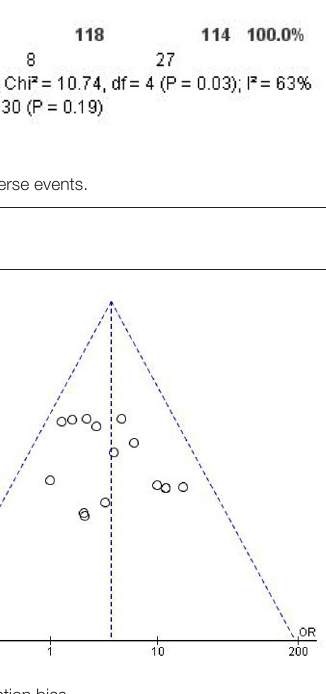
FIGURE 9 | Funnel plot of publication